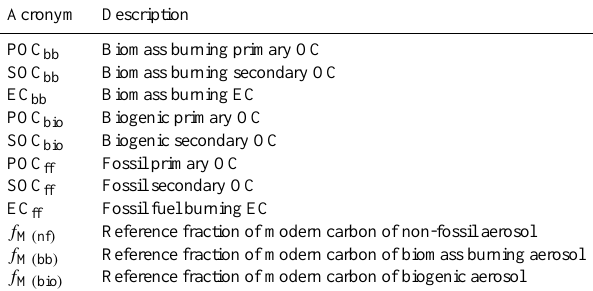
Table 1. List of acronyms used in the paper and the corresponding descriptions.